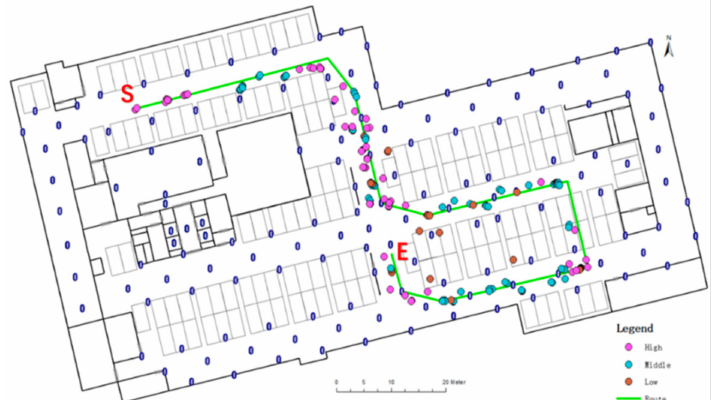
Figure 13. A Case of dynamic positioning.